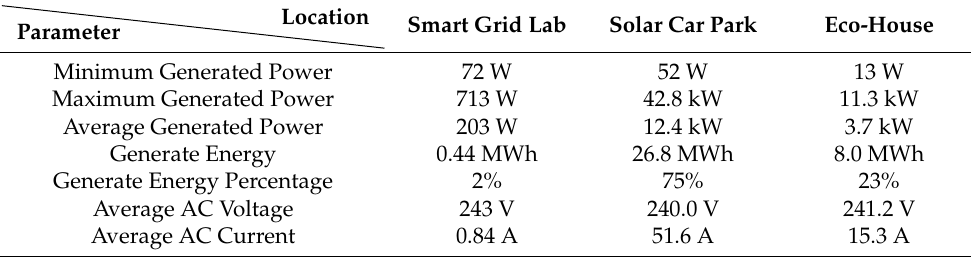
Table 1. Power generation in the first quarter of the year 2020. Parameter